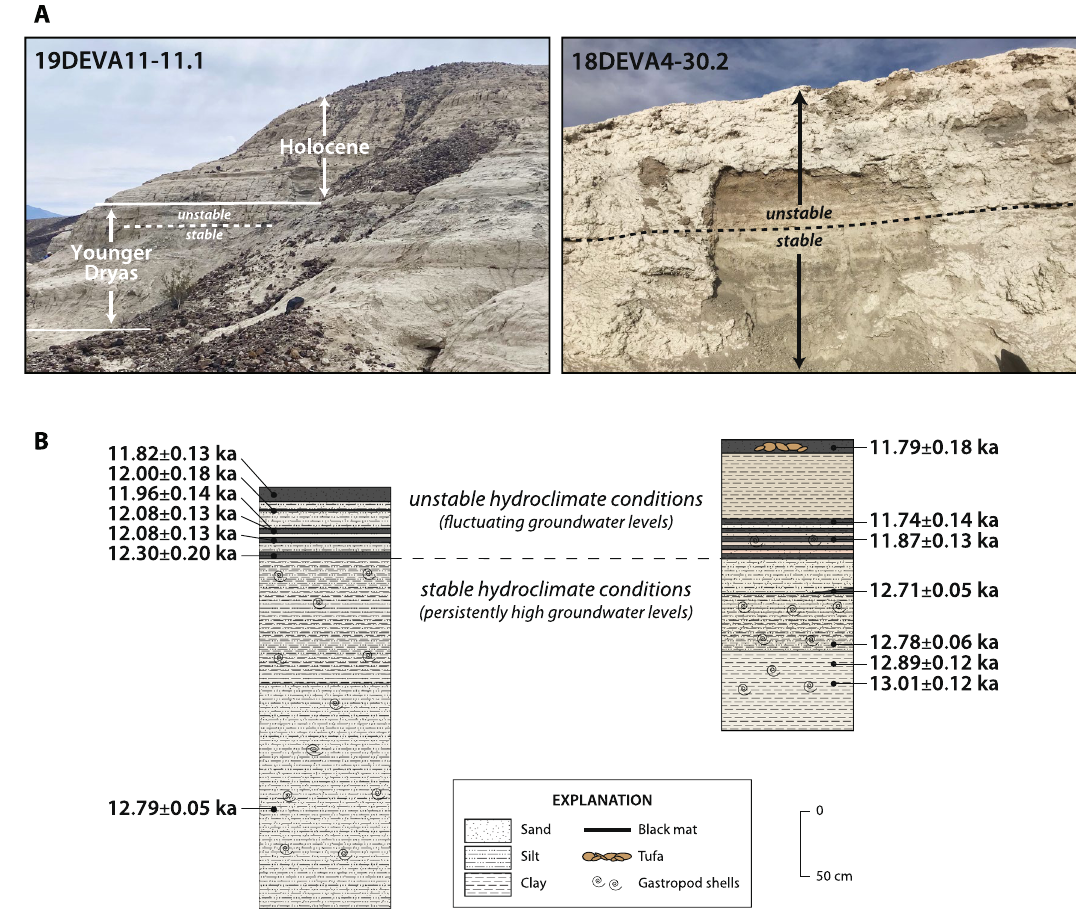
Figure 2. ( a ) Annotated photographs and ( b ) stratigraphic sections of paleospring deposits dating to the Younger Dryas (YD) climate event. Dashed lines represent the stratigraphic transition from high groundwater levels and stable hydroclimate conditions to lower and variable water table levels associated with a drier, unstable hydroclimate within the YD. Details of the dating methods and results, as well as additional sedimentologic data, are included in SI 3 and 4, respectively. Photographs courtesy of the